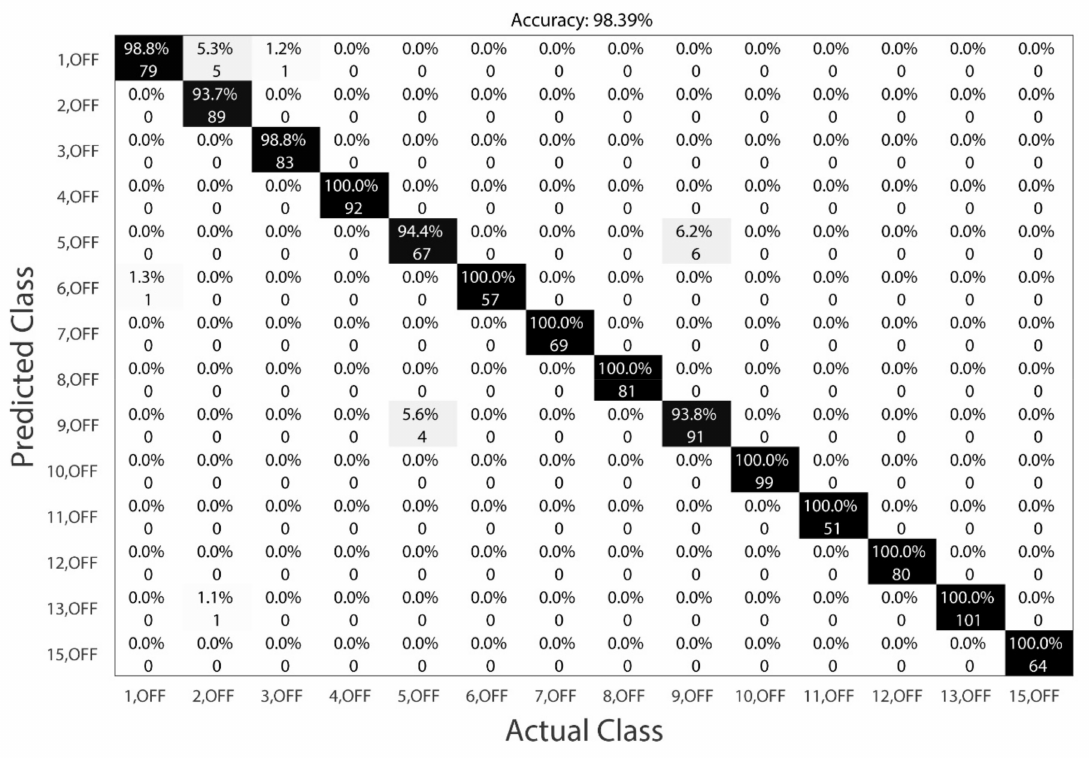
Figure 10. Confusion matrix for recognizing switch-off events of tested appliances using the dictio- nary method.